Question: Draft a figure caption describing what is shown.
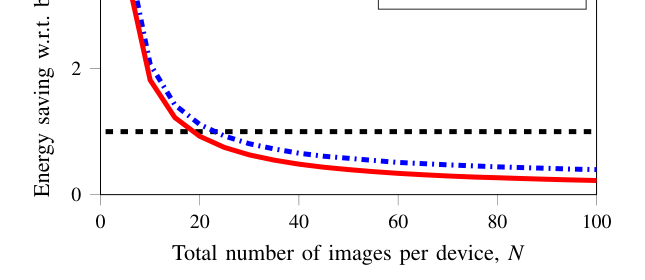
Answer: Energy saving w.r.t. the baseline 𝜂as a function of the total number of images per device, 𝑁.